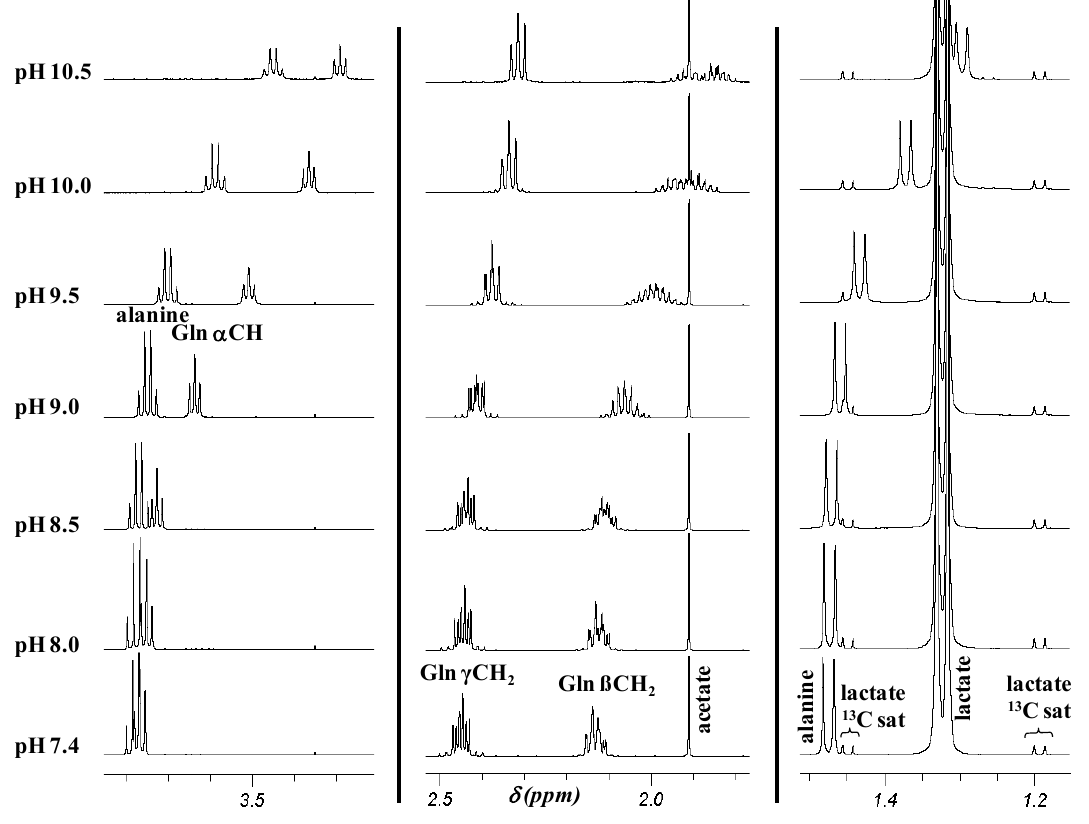
O at various pHs between 7.4 and 10.5. Gln: 2